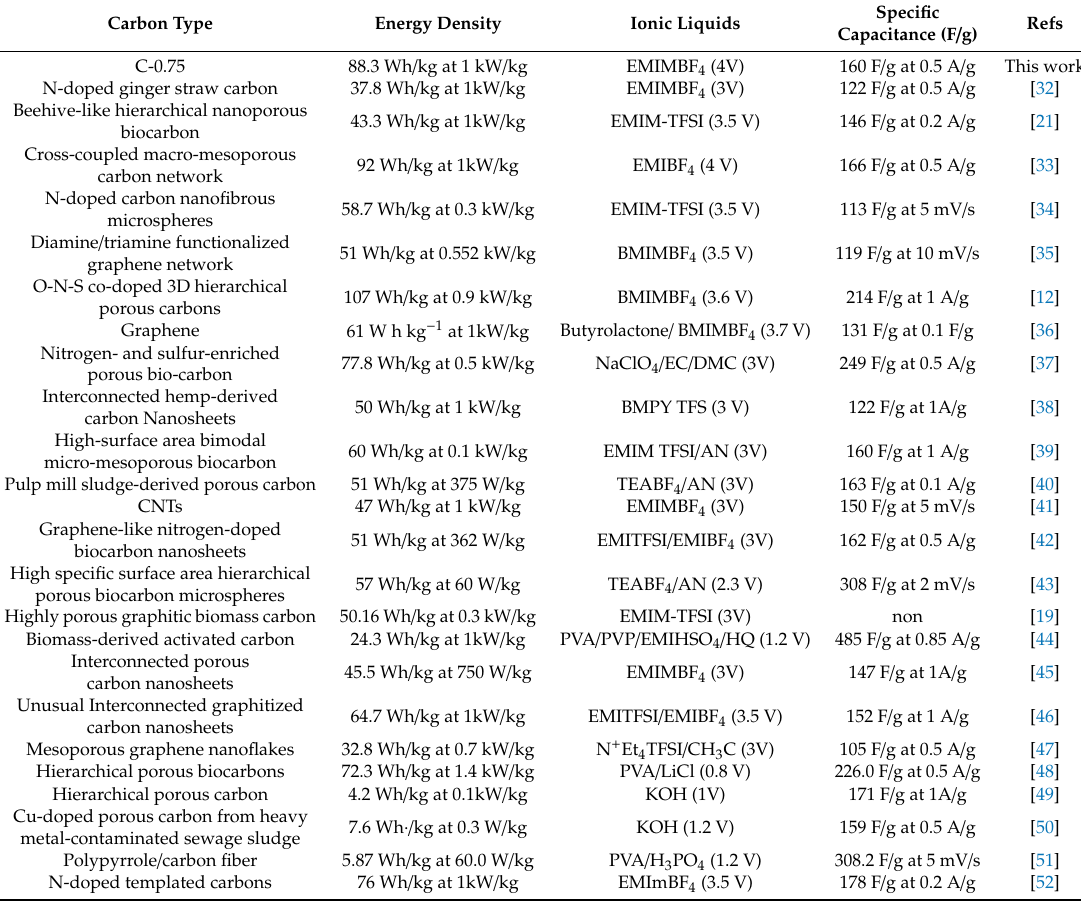
Table 3. Comparison of the energy density of our optimal sample with the counterparts of some hitherto-reported advanced carbon materials. All specific energy densities listed here as references are based upon the mass of the active materials of the